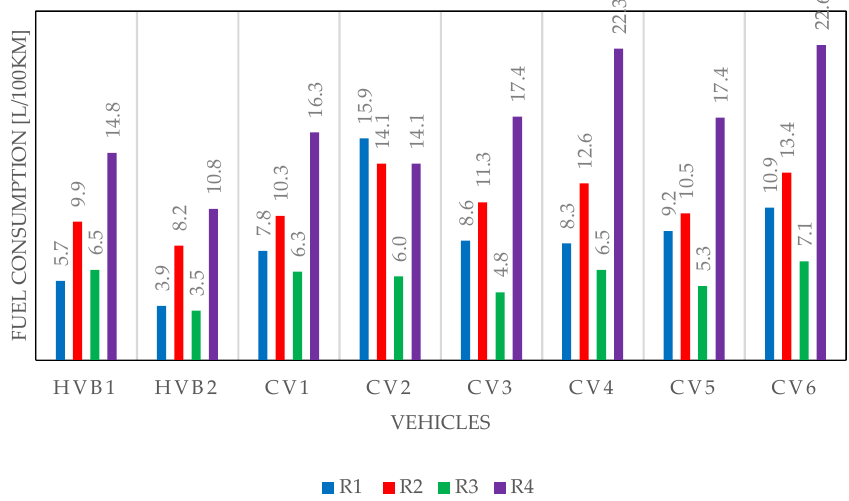
Figure 7. Fuel consumption of the examined vehicles for each route (i.e., R1, R2, R3, and R4).